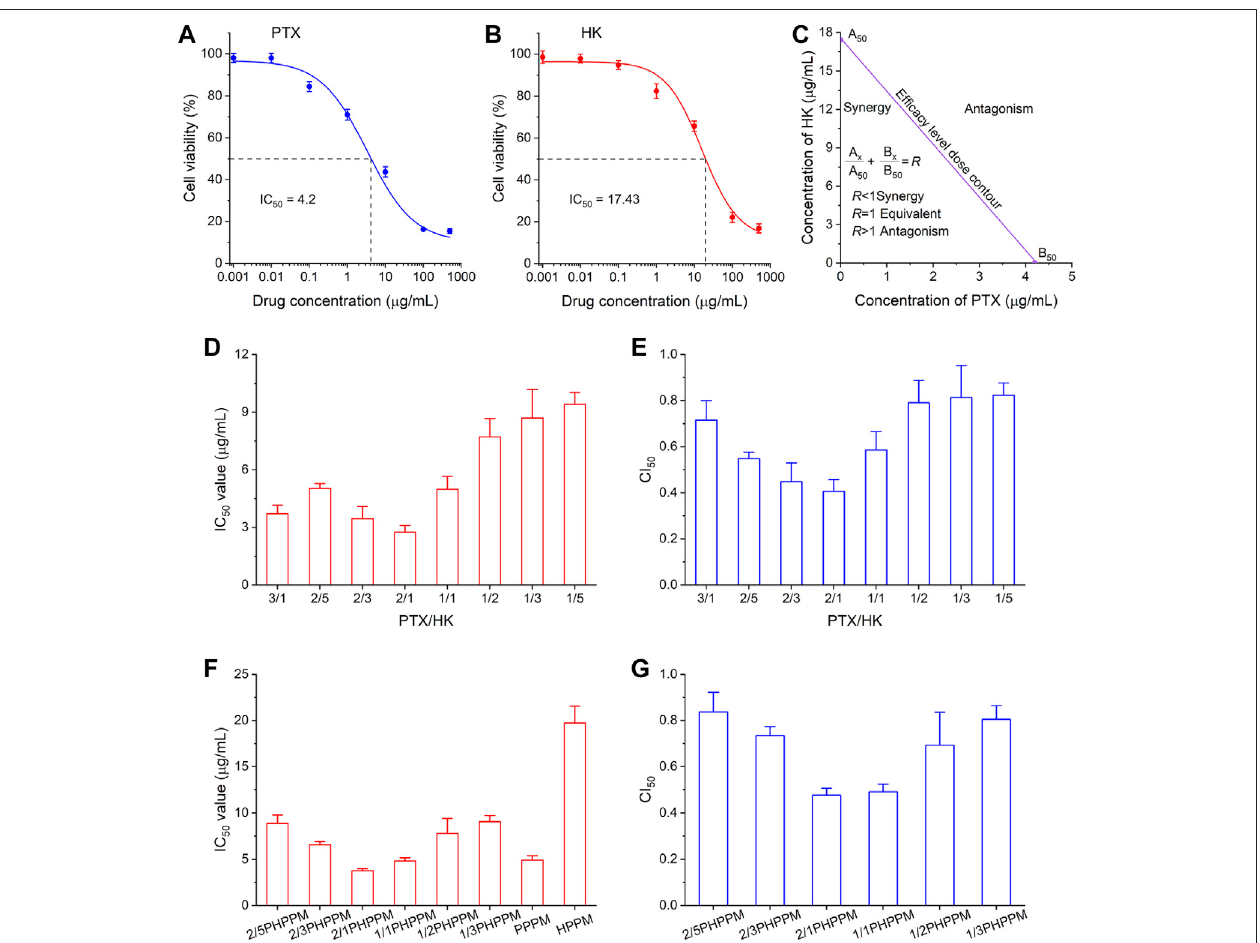
FIGURE 5 | Combination dose screening. (A – B) inhibition of different concentrations of polymeric paclitaxel (PTX) (A) and honokiol (HK) (B) on Hep-2 cells after 48 h. IC 50 (50% of maximal inhibition) of PTX and HK were 4.2 μ g/ml and 17.4 μ g/ml, respectively. (C) pharmacodynamical synergy and antagonistic PTX and honokiol HKregions. (D – E) theIC 50 (D) andcombinationindex 50 (CI 50 ) (E) ofdifferentratiosofPTXandHKinthesynergyareaagainstHep-2cells. (F – G) theIC 50 (F) andCI 50 (G) cocktails of PPM against Hep-2 cells with different drug loading ratios of PTX and HK.